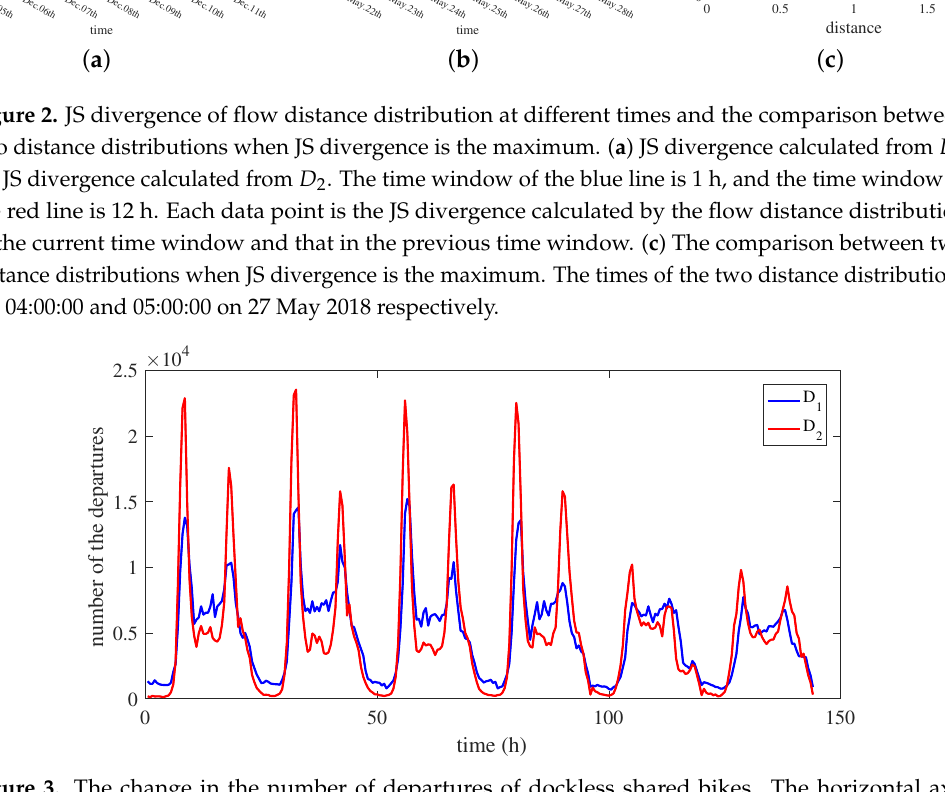
Figure 3. The change in the number of departures of dockless shared bikes. The horizontal axis represents the time interval between the current time in the dataset and the start time. The ordinate axis represents the number of departures within 30 min. The blue line represents the change in the number of departures obtained from D 1 , and the red line represents the changes in the number of departures obtained from D 2